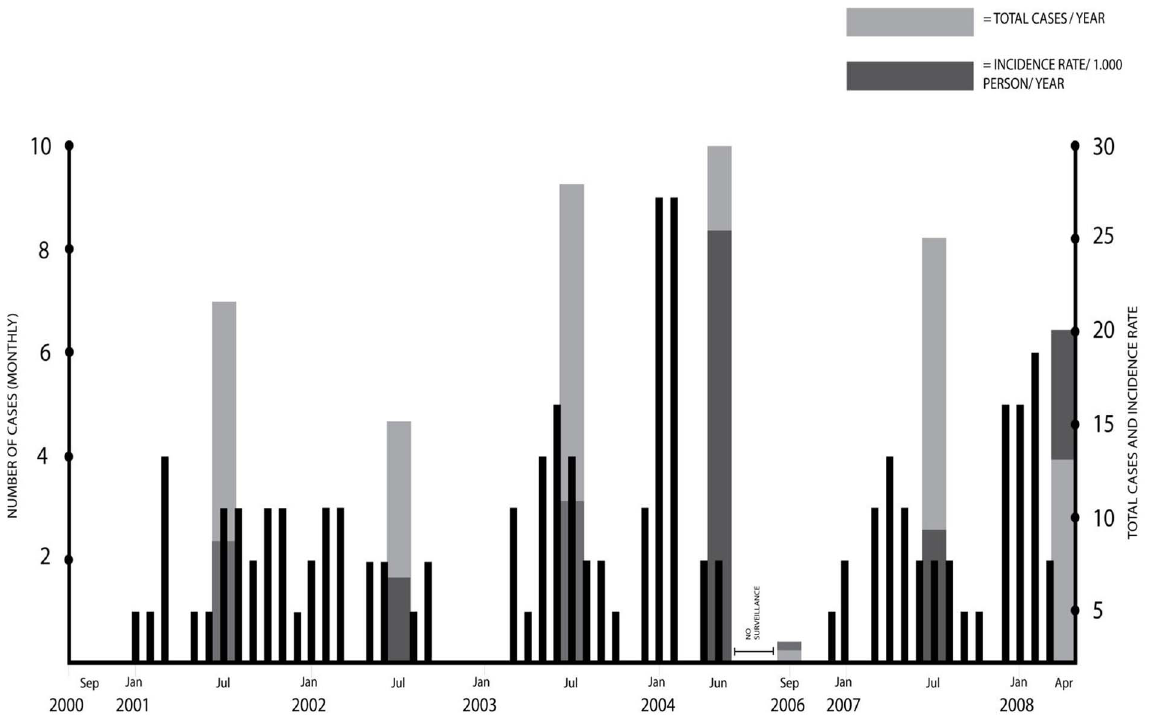
Figure 1. Monthly, annual total number and annual incidence rates for laboratory confirmed chikungunya (CHIK) cases. The number of CHIK cases per month is represented by skinny black rectangles. The total number of cases for a year is indicated by light gray rectangles and the incidence rate for a year is indicated by dark gray rectangles. The rectangles representing annual data are placed at the midpoint (July) for their respective year.